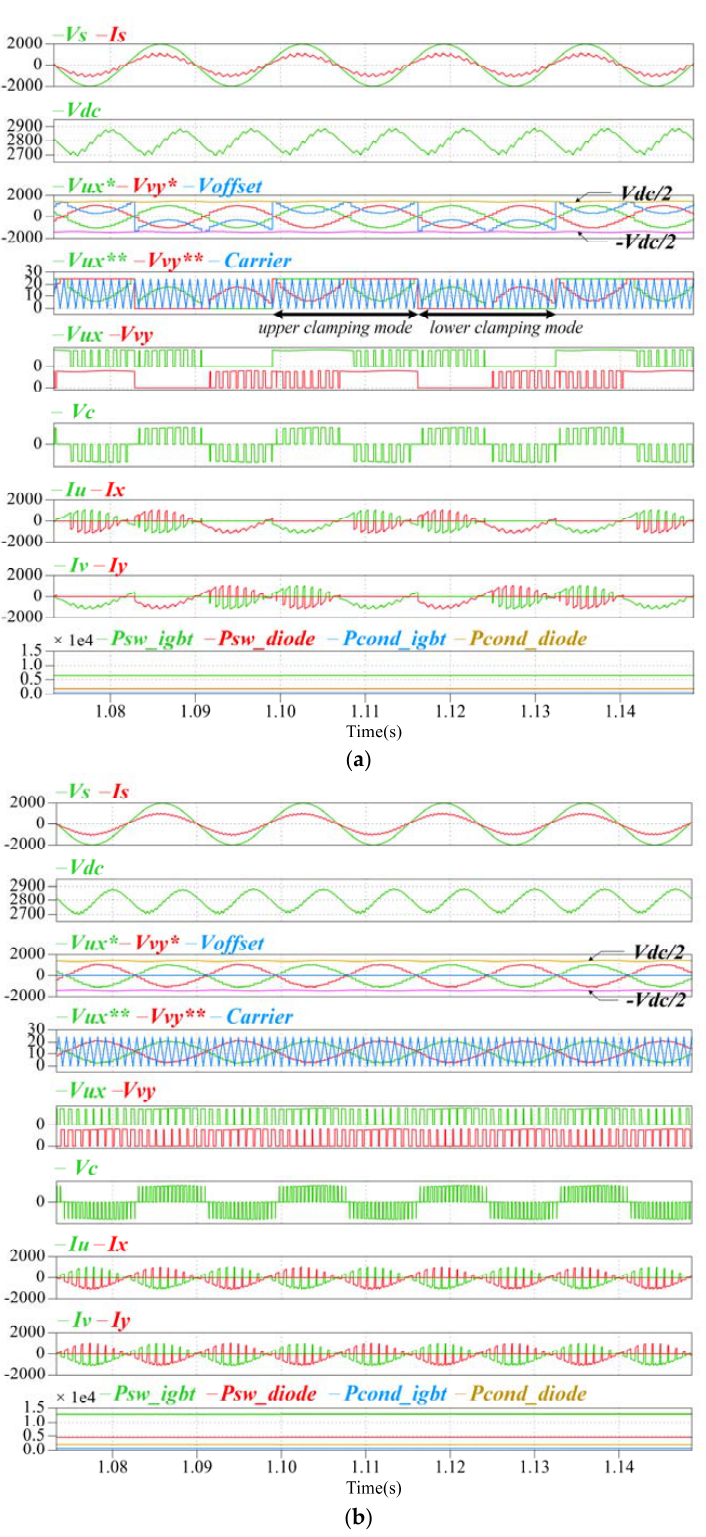
Figure 9. Simulation waveforms of single-phase PWM converter using ( a ) proposed DPWM and ( b ) conventional CB-SPWM (from top, Vs , Is ; Vdc ; Vux* , Vvy* , Vo ff set ; Vux** , Vvy** , Carrier ; Vux , Vvy ; Vc ; Iu , Ix ; Iv , Iy; Psw_igbt, Psw_diode, Pcond_igbt, Pcond_diode